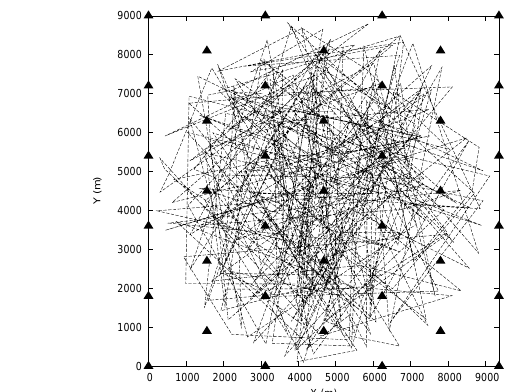
Figure 4. The mobility model and topology in